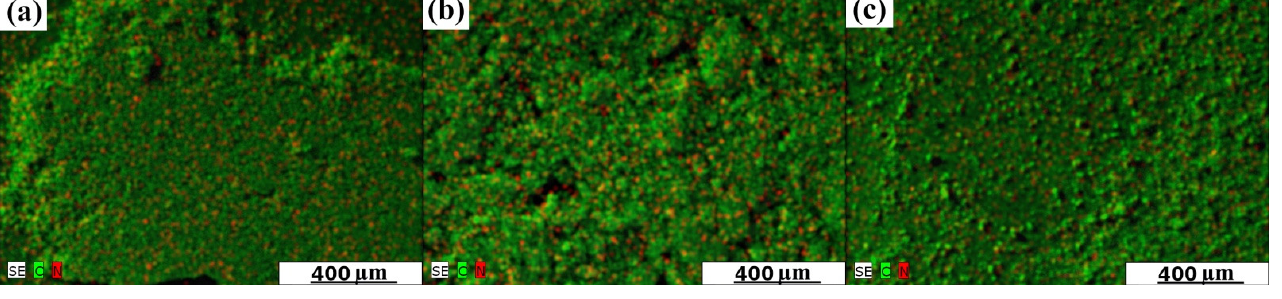
Figure 2. SEM mapping images of all investigated series of the obtained samples: ( a ) AC–O-II; ( b